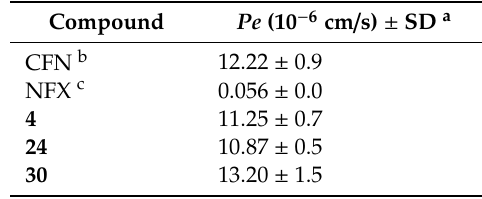
Table 4. The results obtained in parallel artificial membrane permeability assay (PAMPA), expressed as the permeability coe ffi cient ( Pe